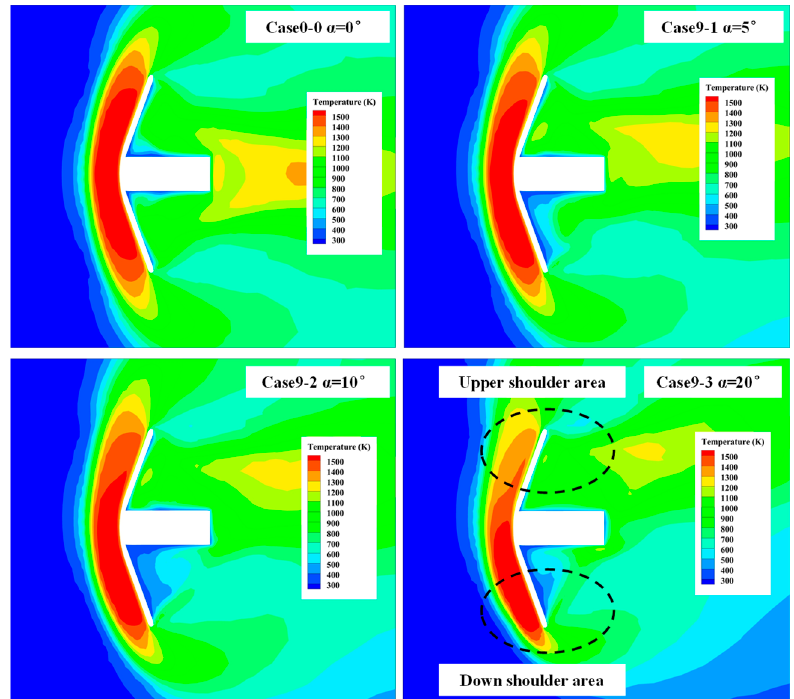
Figure 18. Temperature contours of changing α .